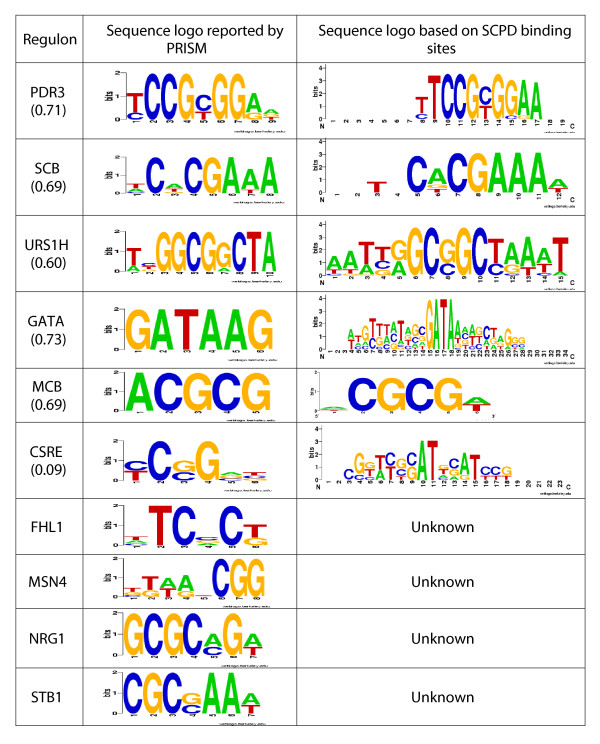
Sequence logos of motifs predicted by PRISM. Number next to regulon indicates Φ score of this sequence logo against the SCPD binding sites. Logos generated by WebLogo [38].